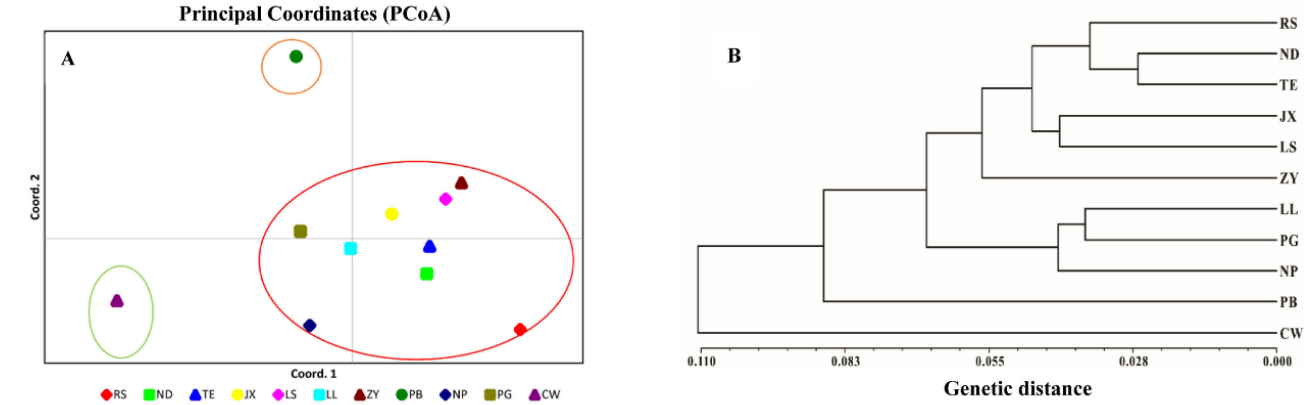
Figure 4. ( A ) Principal coordinate analysis for Chinese firs in 11 sampling localities. The first and second axis explained 57.05% and 23.33% of the genetic variation. For sampling localities abbreviations, see Table 1. ( B ) Unweighted group average method (UPGMA) cluster analysis of 11 sampling localities based on genetic